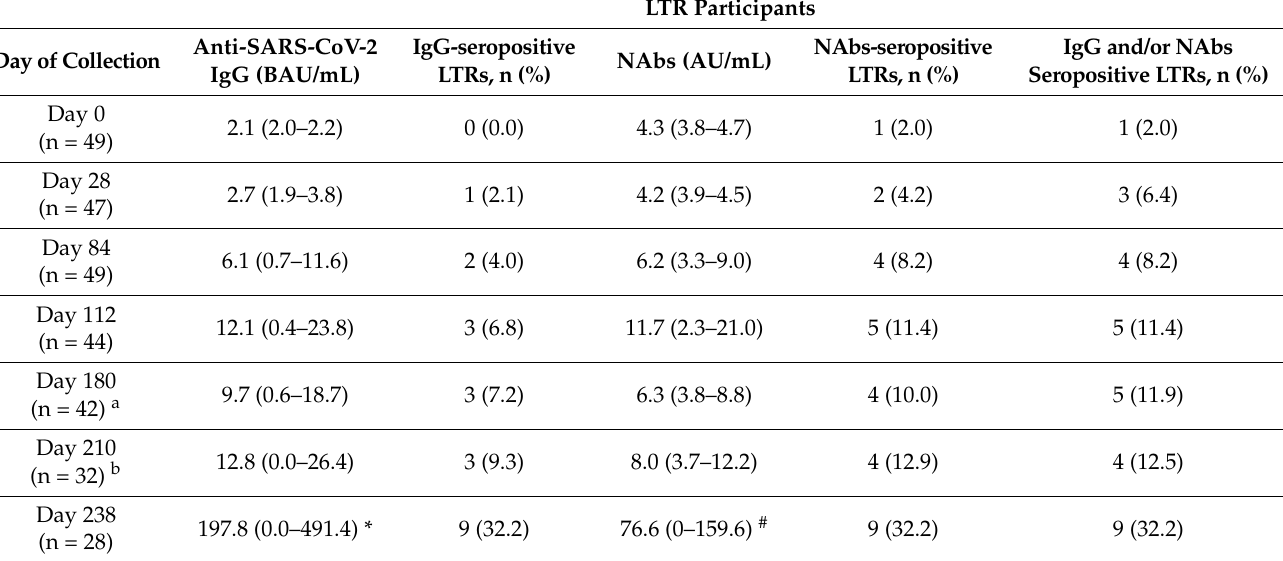
Table 2. Anti-SARS-CoV-2 IgG and NAbs titers, and proportion of seropositive LTRs at each collection time